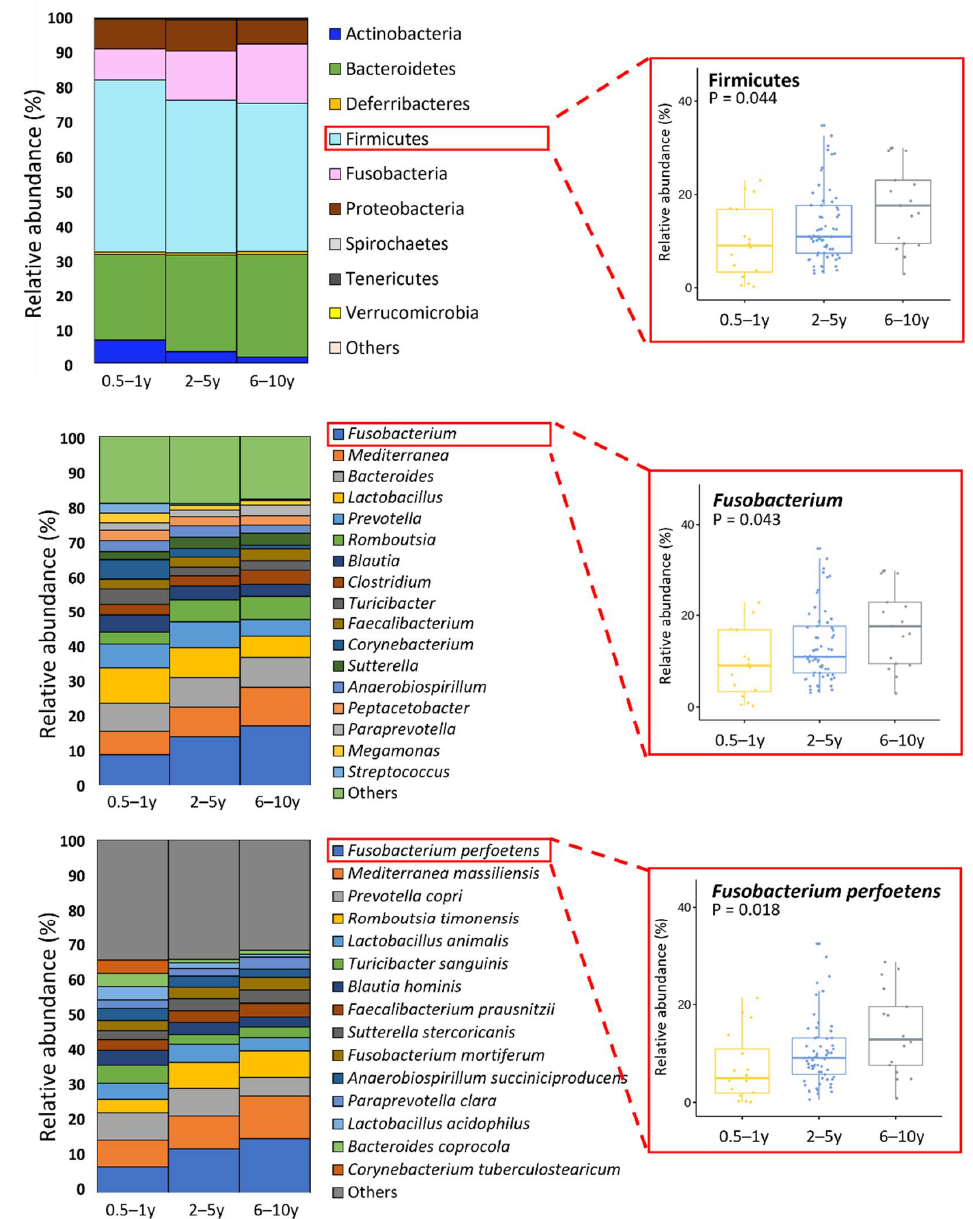
Figure 4. Relative abundances of bacteria at the phylum, genus, and species levels by the age of dogs. Major bacterial groups were selected for chart analysis (phylum ≥ 0.01%, genus ≥ 2%, and species ≥ 3% of total abundance). * Indicates that significantly different bacteria group.